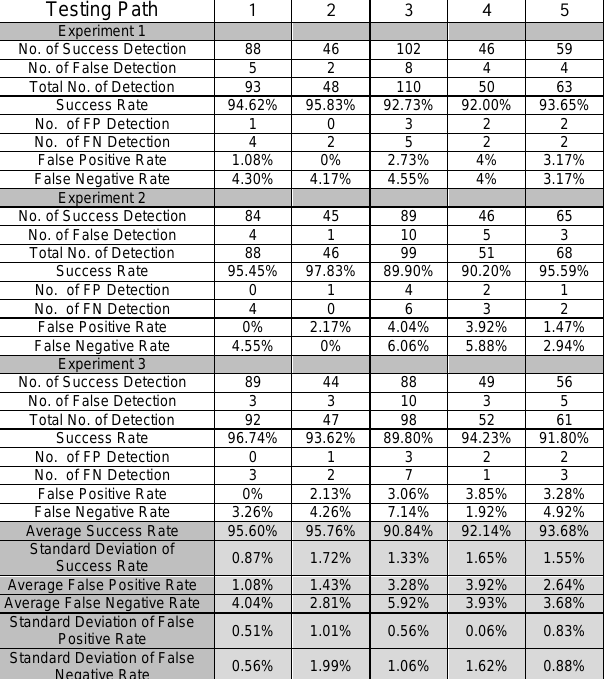
Figure 18. Testing Path 9.